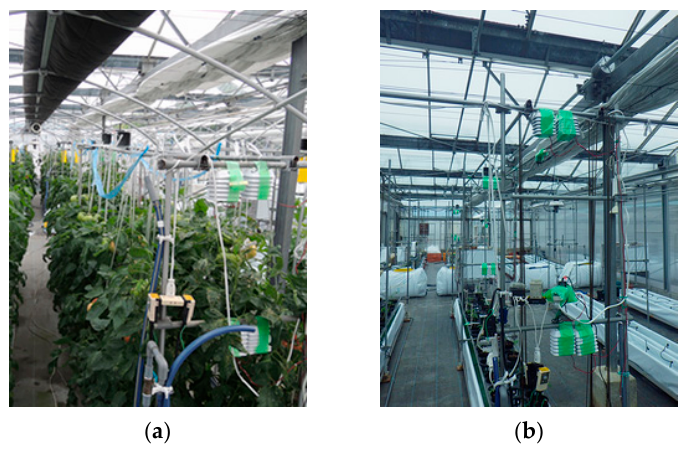
Figure 7. Sensor position for the basic experiment.